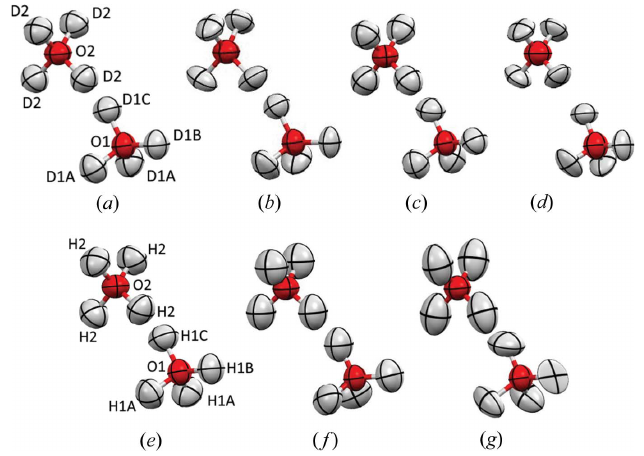
Figure 3 Disordered ( a )–( d ) D 2 O and ( e )–( g ) H 2 O molecules with their anisotropic thermal ellipsoids derived from ( a ) neutron diffraction, ( b ) HAR of synchrotron X-ray data, ( c ) HAR of laboratory X-ray source data, and ( d ) IAM refinement of synchrotron X-ray data, ( e ) neutron data, ( f ) HAR of laboratory source X-ray data, and ( g ) mixed